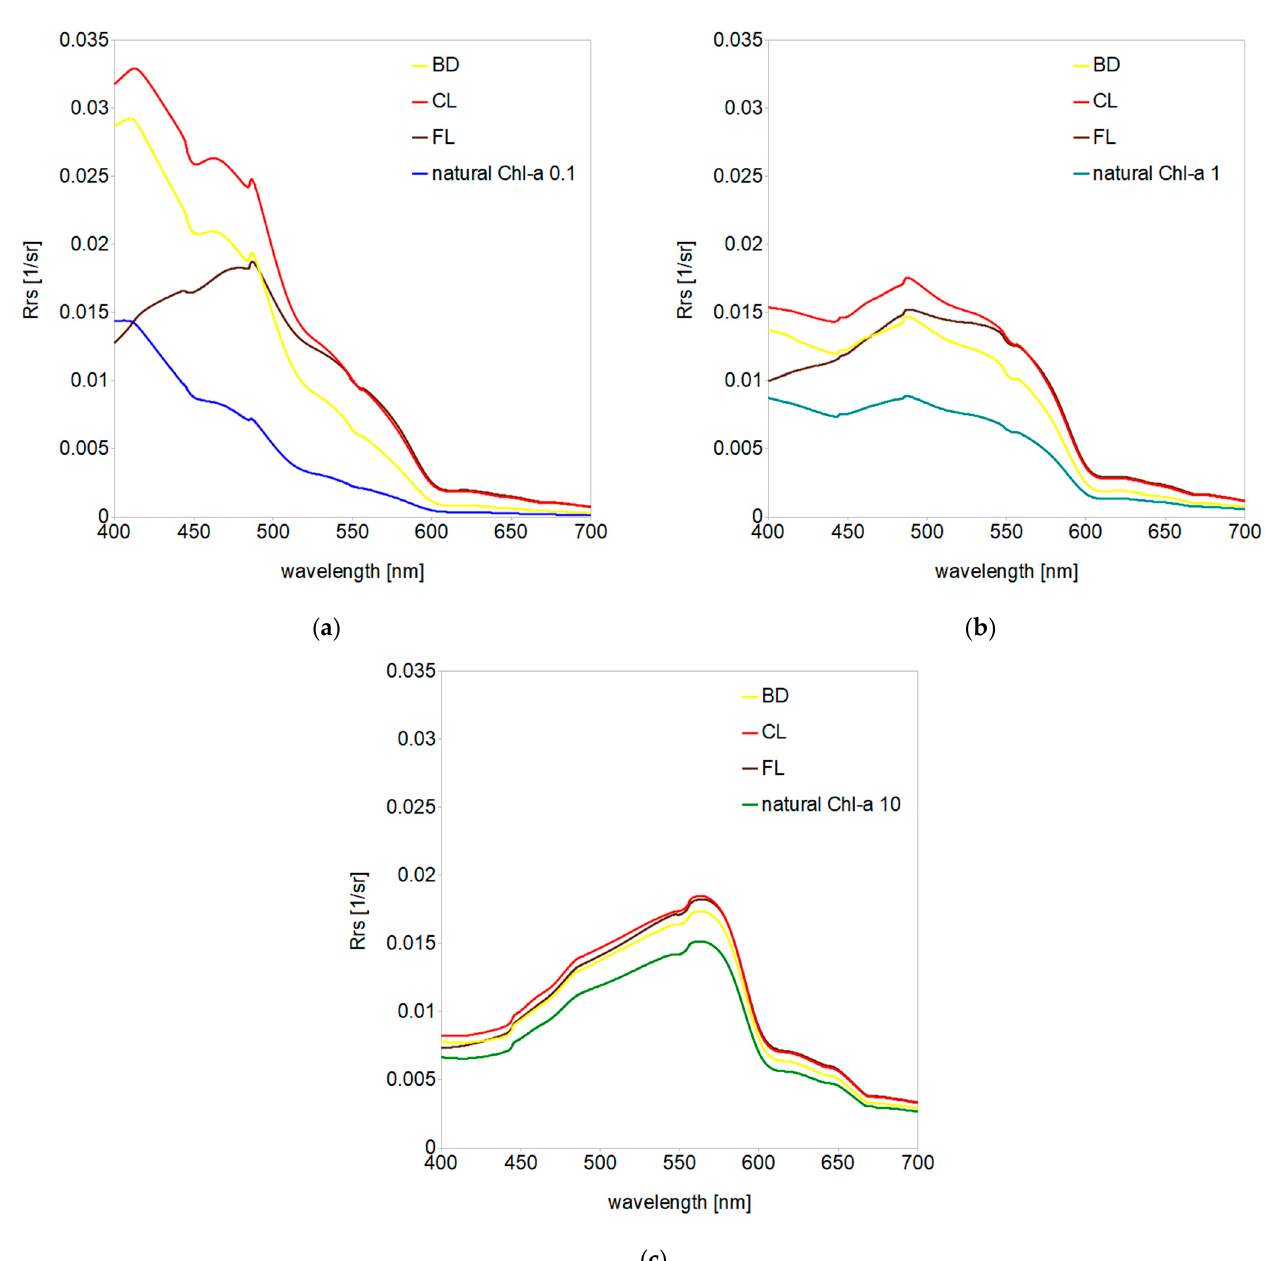
Figure 7. Remote sensing reflectance spectra obtained for three types of unpolluted natural ocean water models (marked by blue and green lines) and polluted by three kinds of dispersed oil: ( a ) oligotrophic ocean water characterized by Chl-a = 0.1 mg/m 3 , ( b ) mesotrophic ocean water characterized by Chl-a = 1 mg/m 3 and ( c ) eutrophic ocean characterized by Chl-a = 10 mg/m 3 .